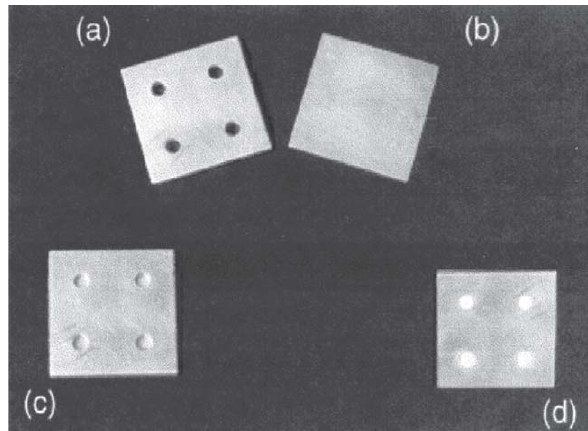
FIGURE 2- Teflon matrix for material pressing. a- matrix with holes; b- Teflon base; c-matrix/base; d-ground SOLITAIRE resin specimens in their respective